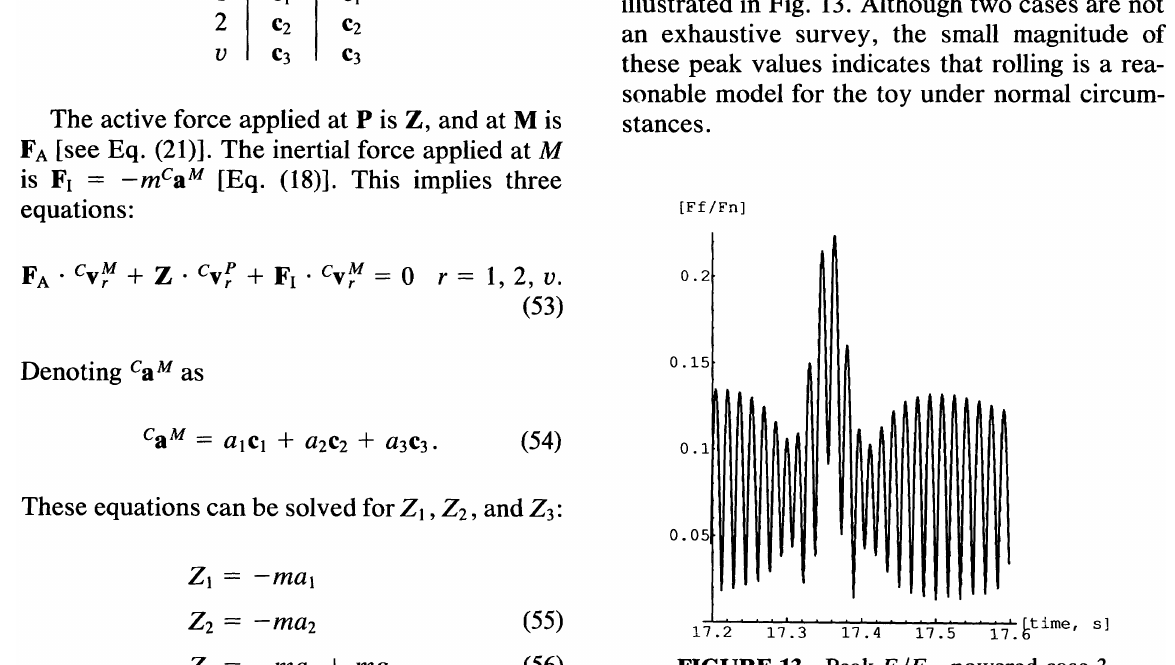
FIGURE 13 Peak FrlF n , powered case